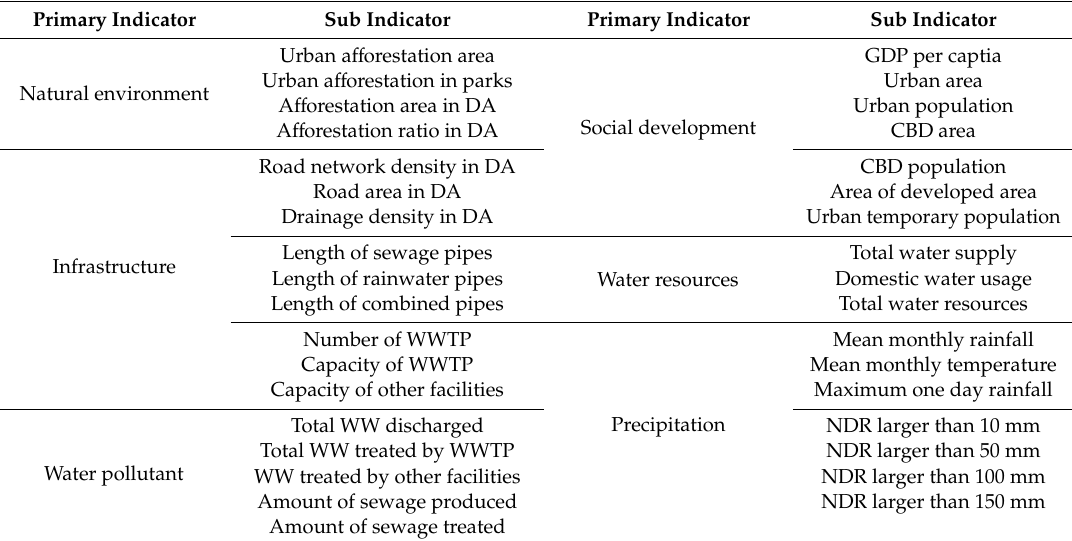
Table 1. Index system for heterogeneity